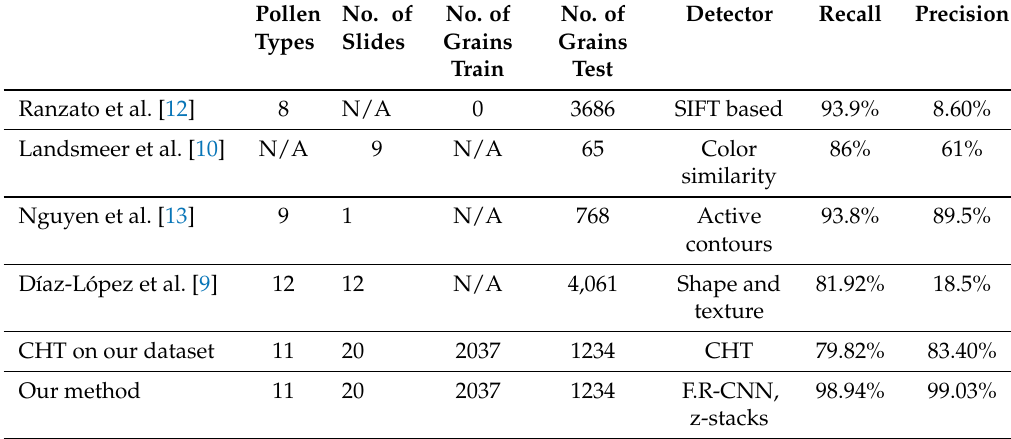
Table 6. Comparison with the latest works published about automatic pollen grain localization. An N/A in a field indicates the non-existence of the data in the work or the impossibility of knowing if any sample has been used in the task. CHT, circle Hough transform.